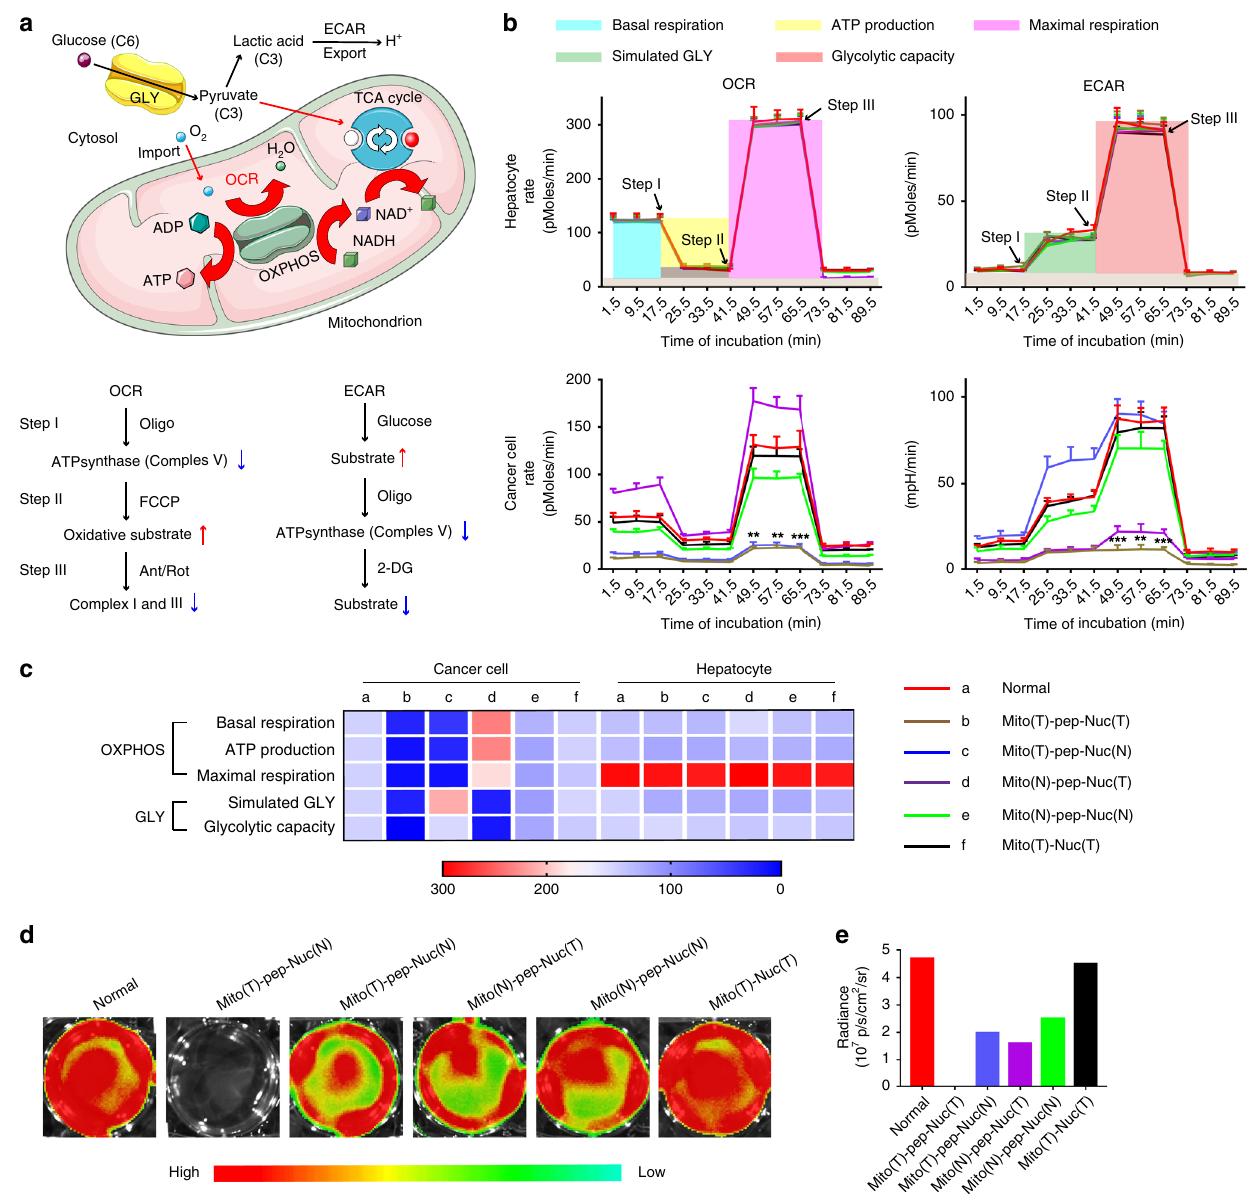
Fig. 4 GLY and OXPHOS activities of treated cells. a A schematic illustrating how GLY and OXPHOS are executed, along with the network showing the essential species involved in these two processes. The chemical effectors involved during the measurement of OCR and ECAR are shown at the bottom. Red and blue arrows stand for the up- and down-regulation of metabolic activities, respectively. b Pro fi les of OCR and ECAR measured by a Seahorse XF- 24 analyzer, whose level re fl ected the activities of OXPHOS and GLY in real time. Such an analysis was conducted right after the two-round laser irradiation. Data are presented as mean ± s.e.m. ( n = 3). c A heat-map showing the values of basal respiration, ATP production, maximal respiration, and the simulated GLY and glycolytic capacity that were respectively associated with OXPHOS and GLY. These pro fi les were measured on the basis of plots shown in b . The captions shown on the right are valid for both b and c . A color bar on the right indicates the color scales. d Bioluminescence micrographs of luciferase-transfected HCT-116 cells that were incubated with different types of platforms before laser irradiation. D -Luciferin was added into the culture medium of cells right after the laser irradiation to show the availability of ATP. e Radiance intensity of cells shown in d . The “ T ” and “ N ” were used to demonstrate the presence and absence of targeting moieties toward either nucleus or mitochondrion, respectively. For the Mito(T)-Nuc(T), it represented the platform composed of nuclear-targeting WONPs (Nuc(T)) and mitochondrion-targeting MSNs (Mito(T)) that was covalently linked to each other via a linker that was non-cleavable by Cathepsin B. P values were calculated by one-way ANOVA (*** p < 0.001, ** p <